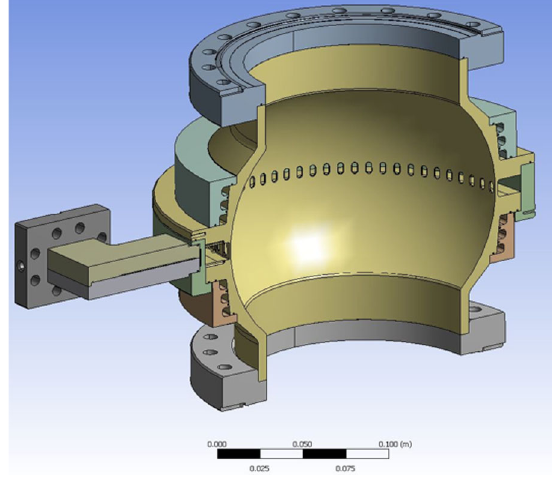
FIG. 3. Section view of the assembled XBOC.